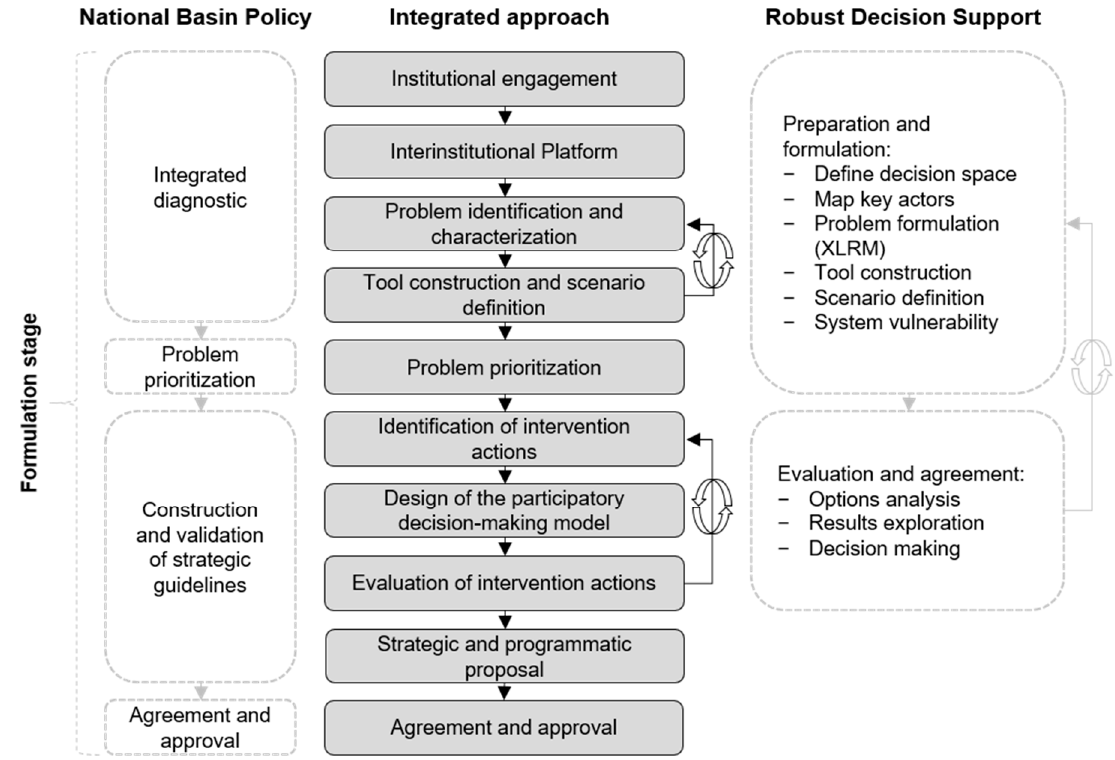
Figure 2. Framework to develop a Basin Master Plan based on model-driven participatory-based decisions. The new approach (center panel) allows grounding and implementation of the National Basin Policy guidelines (left panel) [68] and the robust decision support approach (right panel)